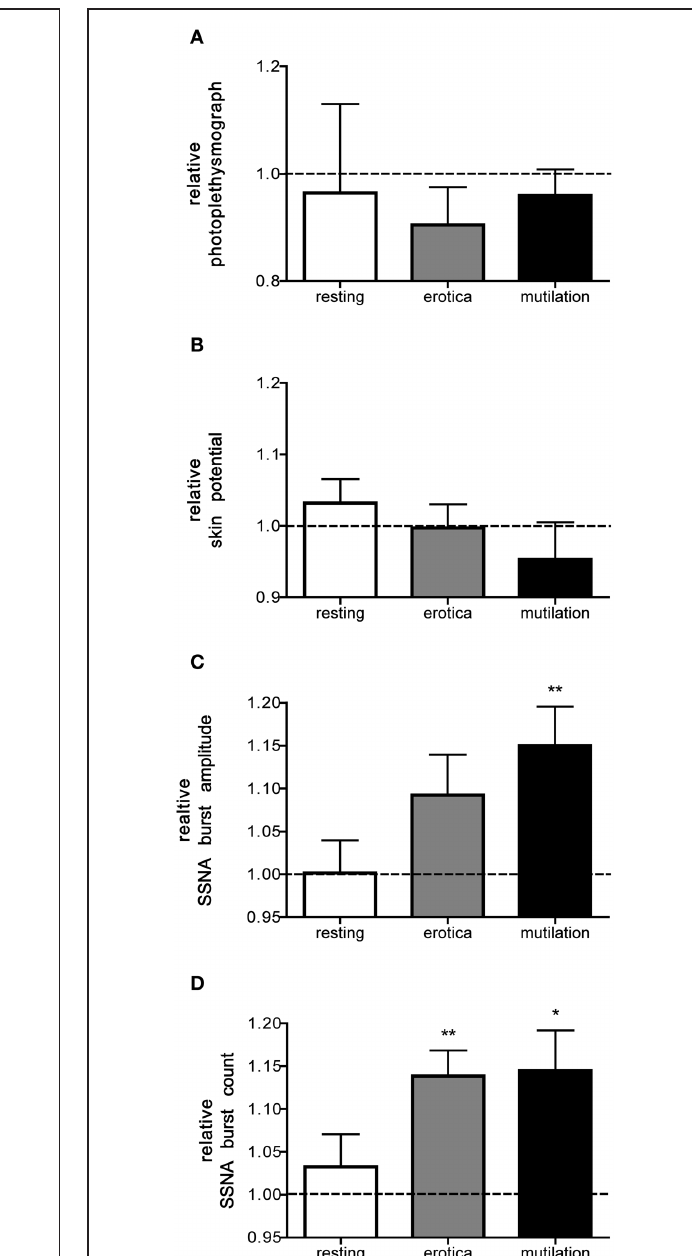
FIGURE 2 | Mean ± SE absolute values of blood pressure (A), heart rate (B), respiratory rate (C) and total burst count of skin sympathetic nerve activity (D) across the four conditions. As can be seen, no statistical differences exist except for the SSNA burst count. Erotica and mutilation were statistically different from both resting and neutral. ∗ p < 0 . 05. Abbreviations: mmHg = millimetres of mercury.